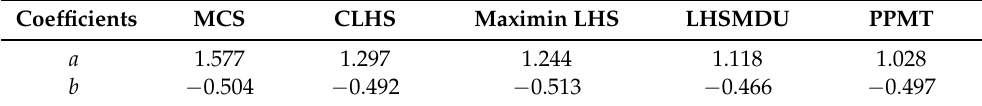
Table 3. The coefficients of the power law functions in the case where the OOIP variables are